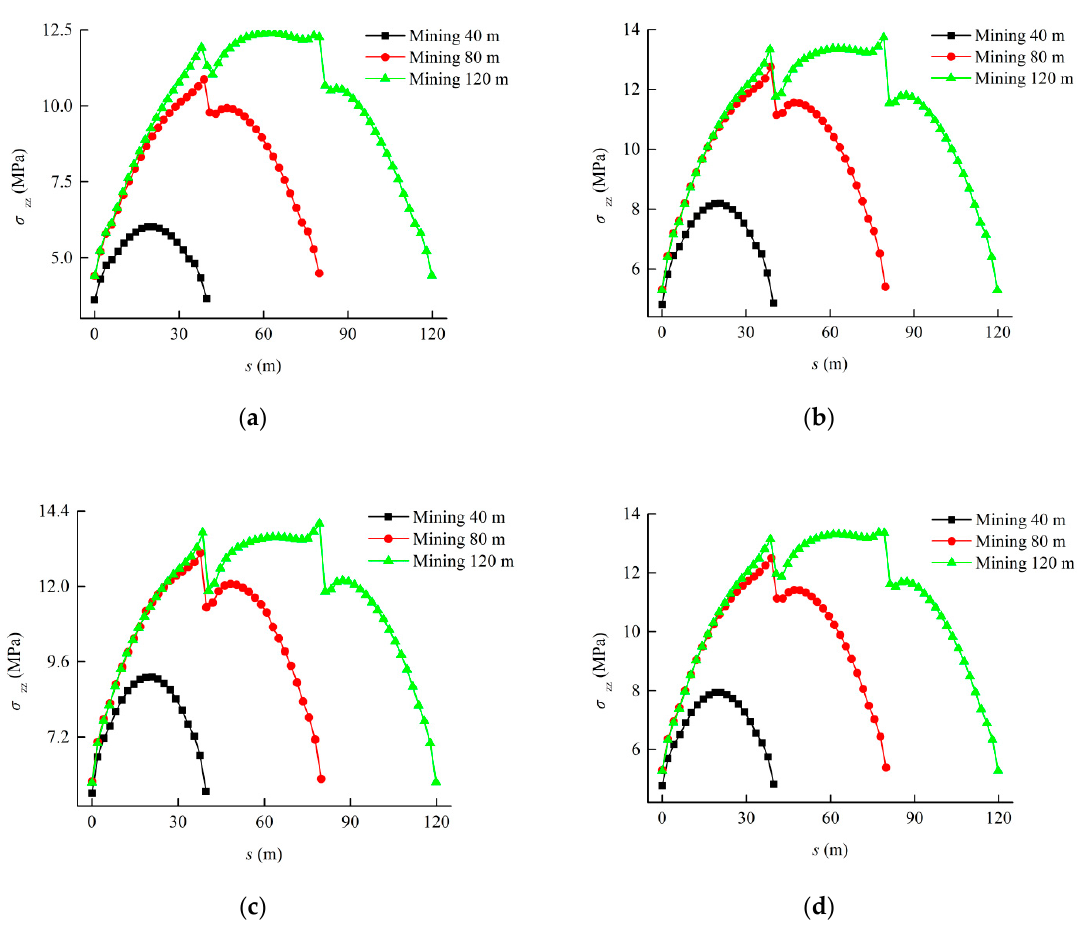
Figure 16. Internal stress of the backfill at different mining distances when the goaf was filled by cemented rockfill with different granule gradations. n = 0.2 ( a ); n = 0.4 ( b ); n = 0.6 ( c ); and, n = 0.8 ( d ).